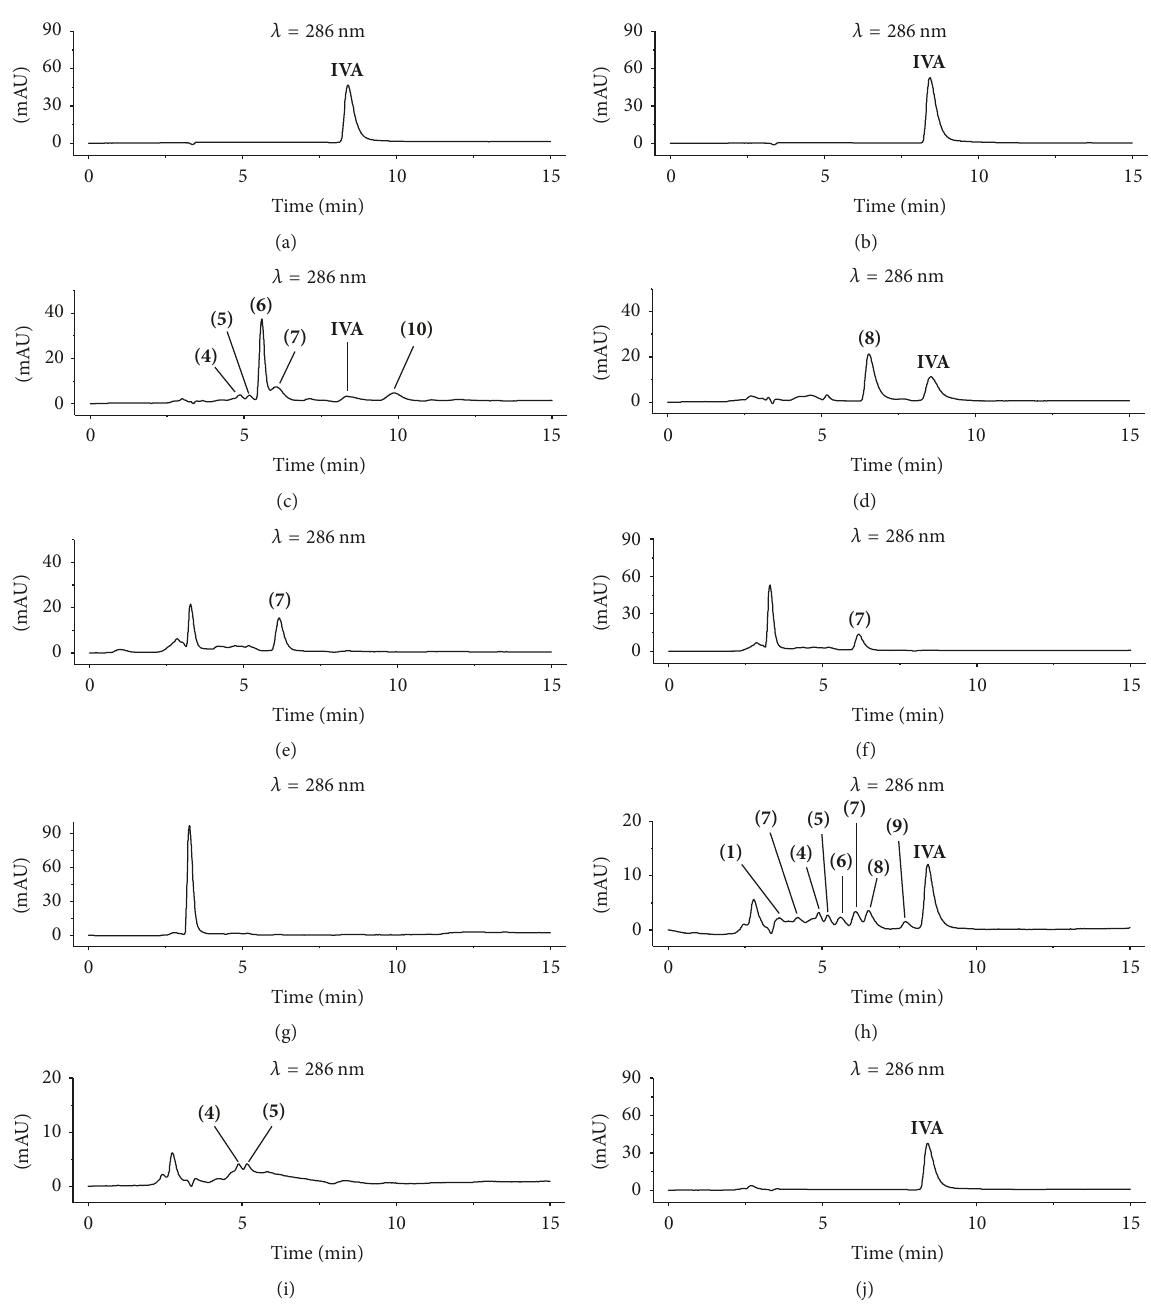
Figure 4: Chromatographic set showing degradation products generated in various conditions at 286 nm: (a) thermal degradation (solution), (b) thermal degradation (powder), (c) acid degradation, (d) alkaline degradation, (e) oxidation (3% H 2 O 2 ), (f) oxidation (7.5% H 2 O 2 ), (g) oxidation (15% H 2 O 2 ), (h) photolysis (24h), (i) photolysis (48h), and (j) photolysis (powder, 120